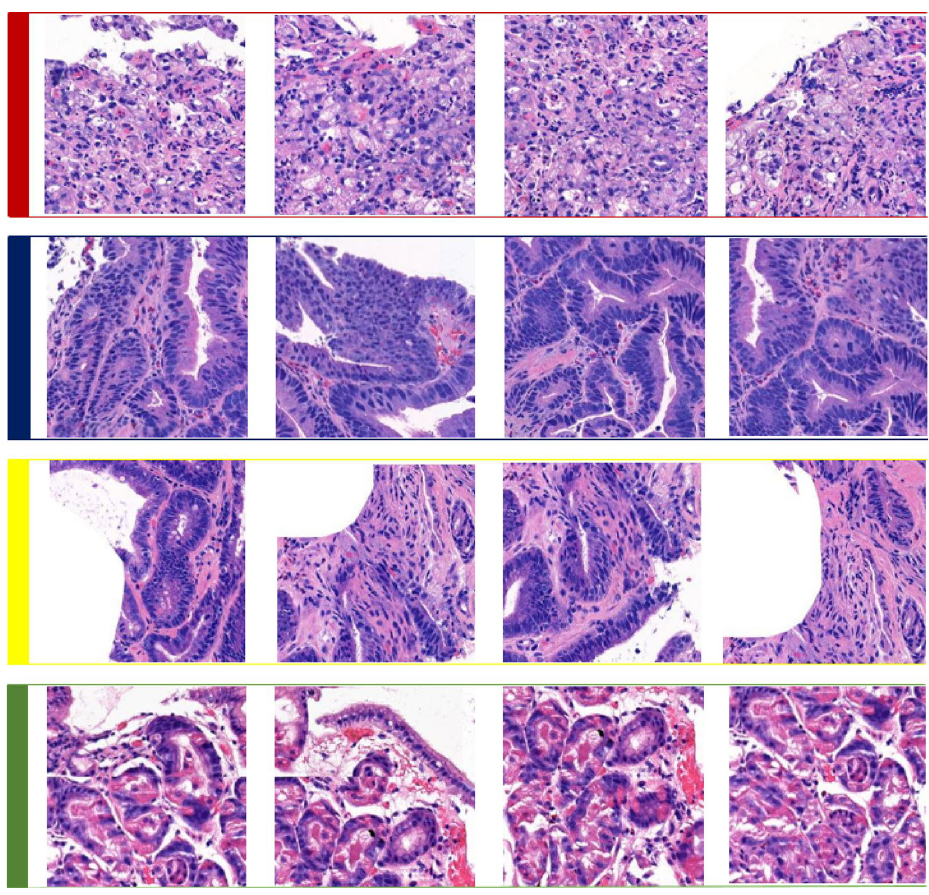
Figure 3. Four types of pathologic classes in whole-slide images of the stomach: red (1st row), navy blue (2nd row), yellow (3rd row) and green (4th row) annotated patches represent malignant, dysplasia, uncategorized, and benign classes, respectively.